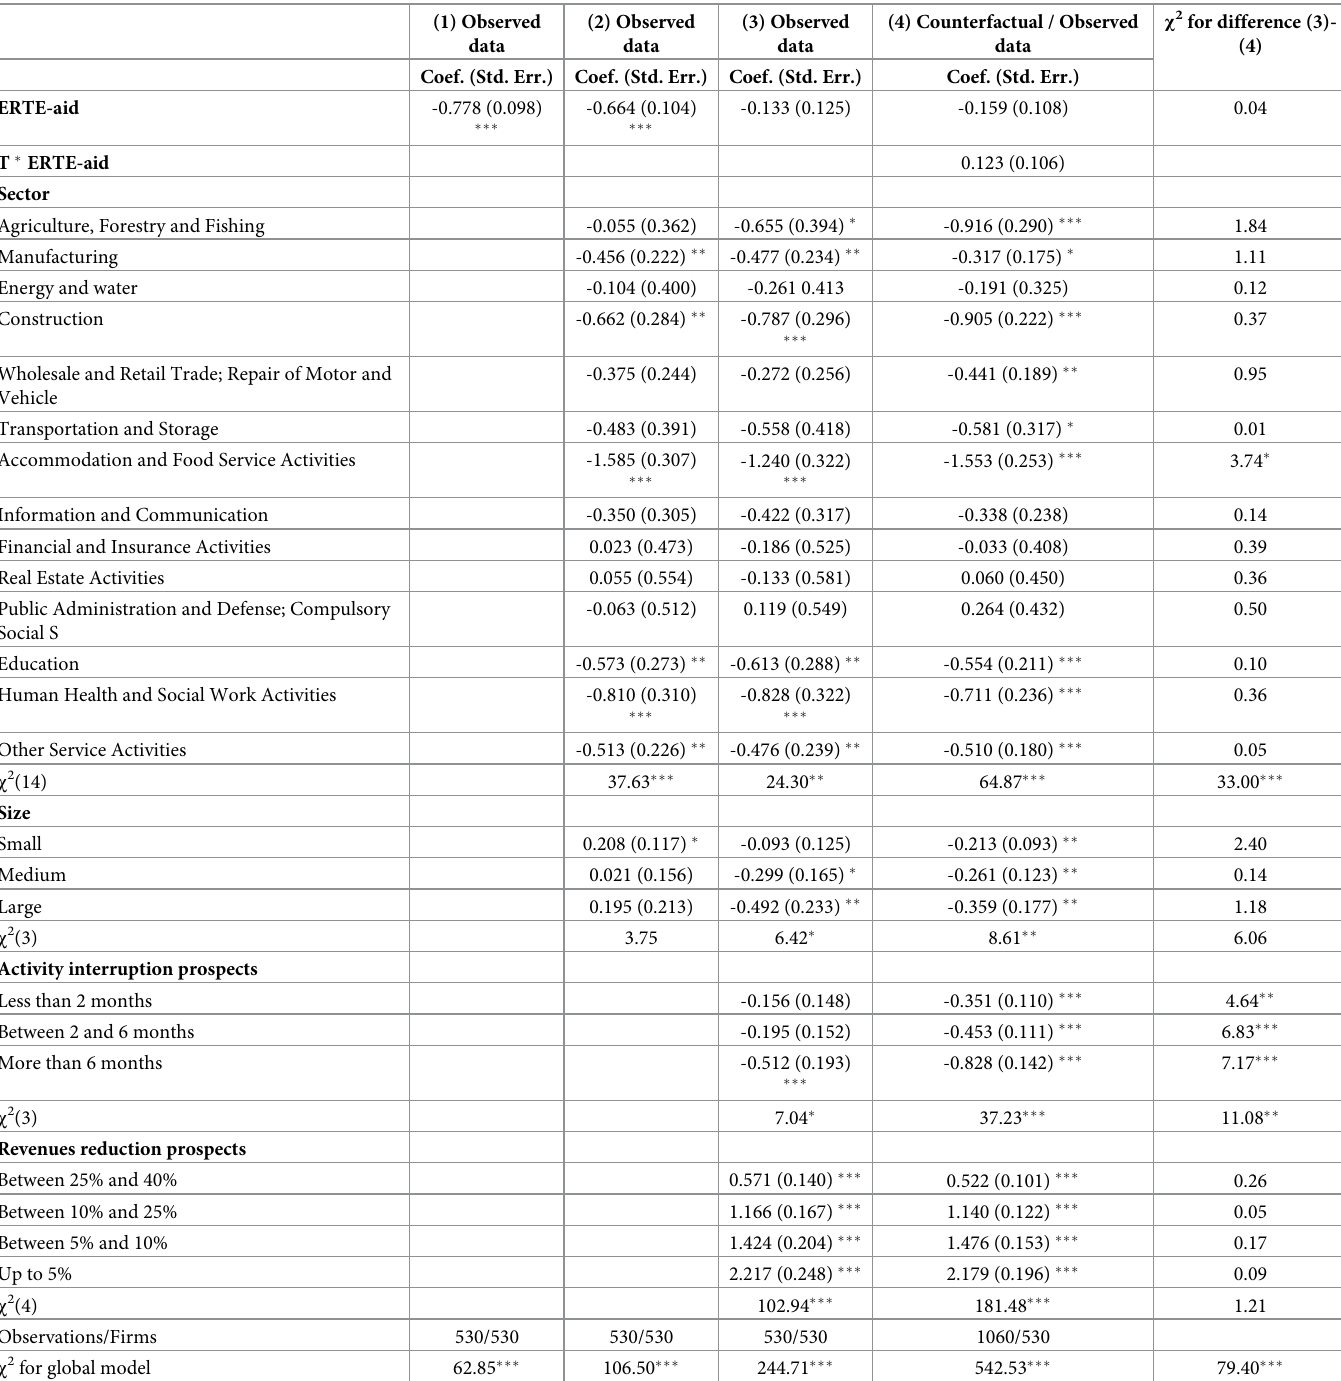
Table 6. Ordered probit estimation: ERTE policy